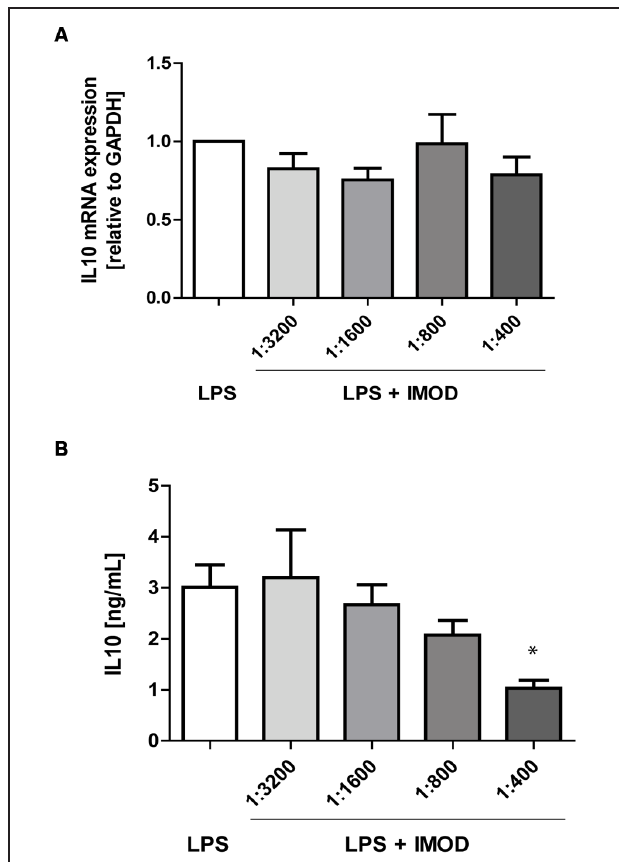
FIGURE 3 | IMOD does not affect IL-10 expression by LPS-stimulated dendritic cells. DCs were stimulated with LPS alone or in combination with IMOD and IL-10 expression was measured after 6 and 18 h at mRNA (A) and protein level (B) , respectively. The data are represented as mean ± standard deviation of at least three independent experiments. ∗ P < 0.05 IMOD/LPS treated vs. LPS stimulated samples.